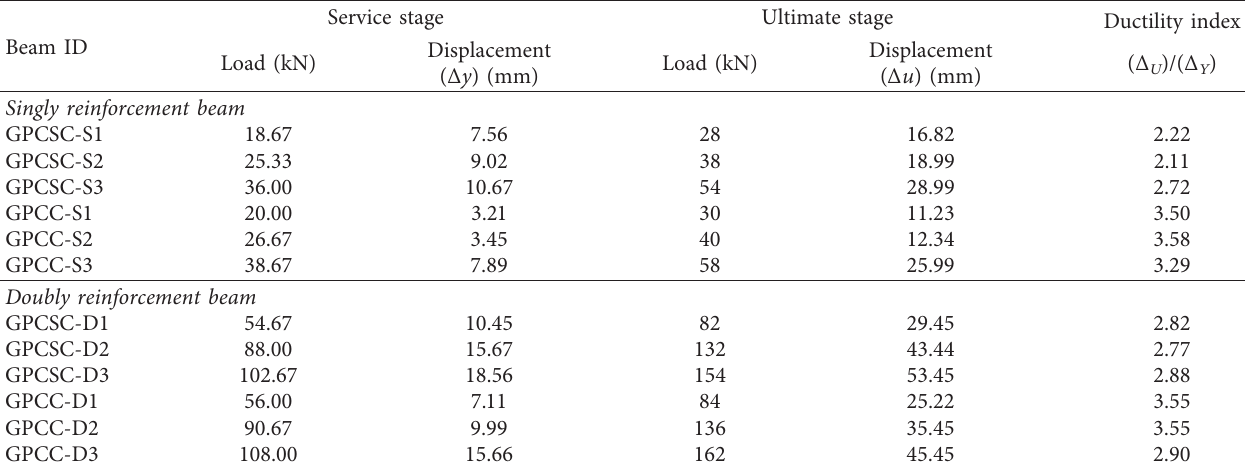
Table 8: Deflection at service stage and ultimate